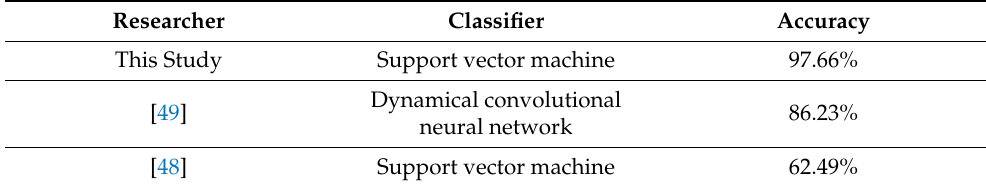
Table 8. Intra-subject classification accuracy.